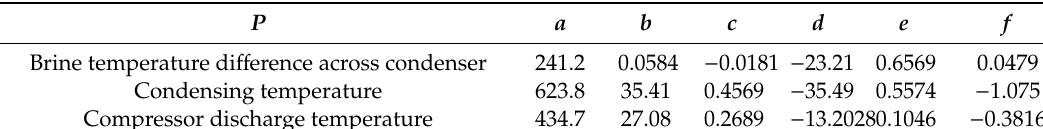
Figure 13. Relationship between MSSFF and secondary fluid temperature di ff erence across condenser and evaporator at standard T OD . Table 4. Coe ffi cients of condenser SFFR correlations.